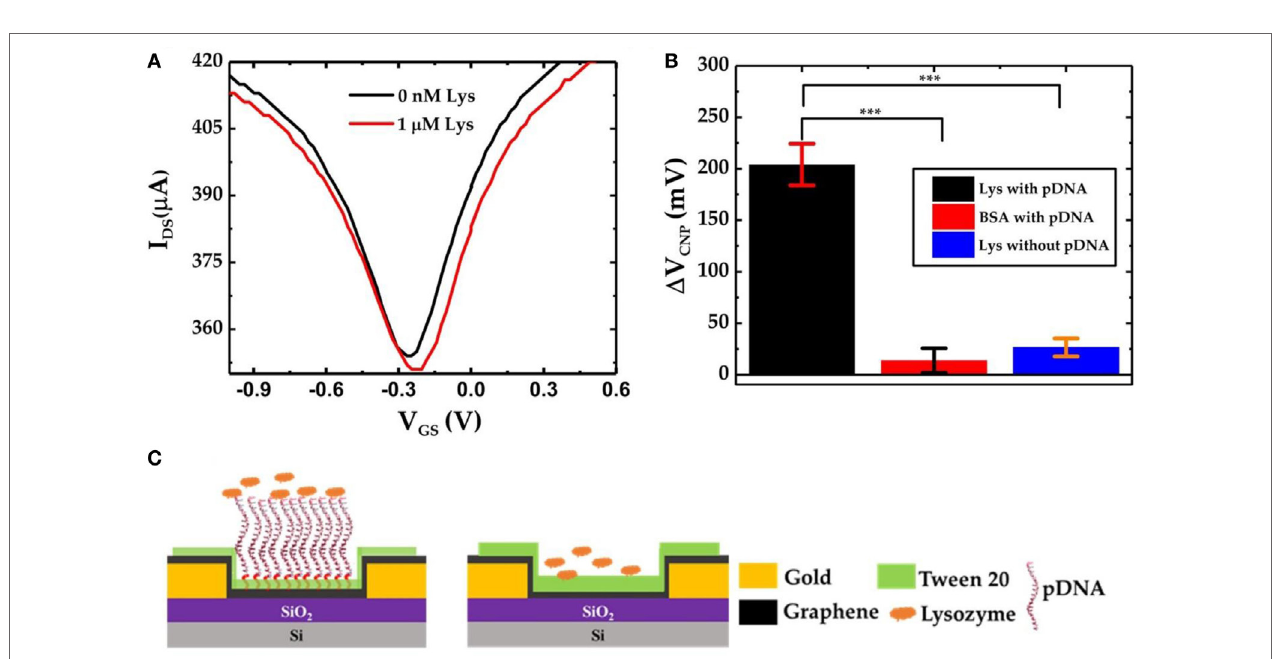
FigUre 5 | (a) I DS – V GS characteristics of graphene-PBASE field-effect transistor (FET) [without probe DNA (pDNA)] device before and after exposure to 1 µM lysozyme; (B) comparative bar chart showing the Δ V CNP of the graphene-PBASE FET devices with the pDNA functionalization after exposure to 1 µM lysozyme and 1 µM bovine serum albumin and without pDNA functionalization ( n = 3, error bar = 1 SD, paired Student’s t -test, *** p < 0.001); and (c) the schematic diagram of the graphene field-effect transistor with pDNAs (left) and without pDNAs